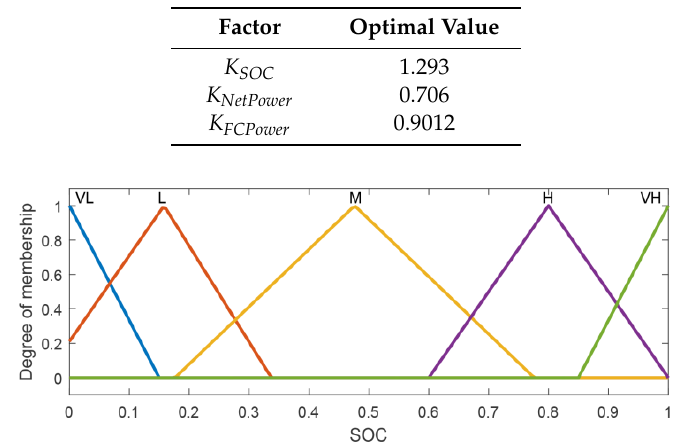
Figure 10. Optimized membership functions of the first input of FLC.